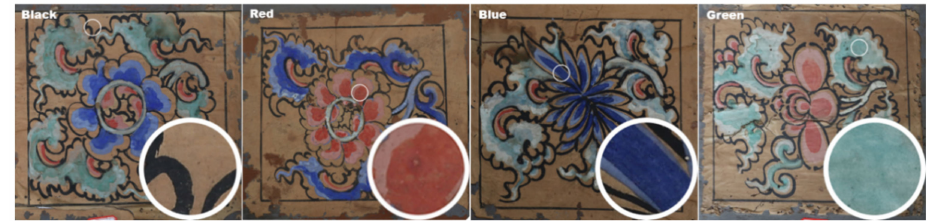
Figure 3. The sampling points for the pigment